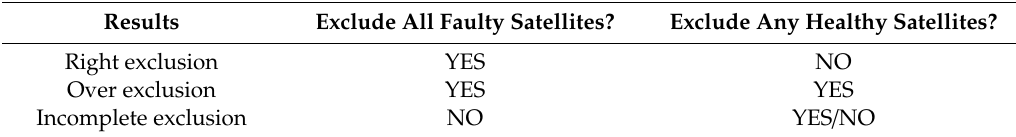
Table 3. Possible results in GNSS fault exclusion